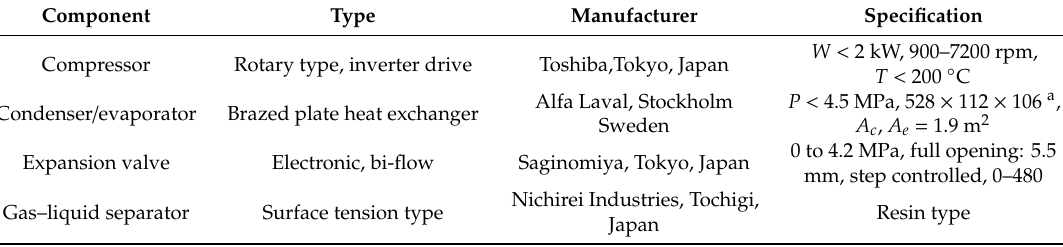
Table 1. Main components of the experimental